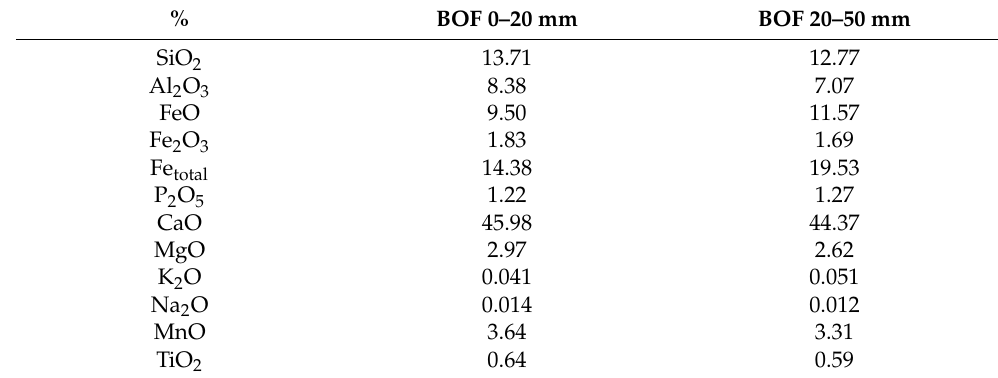
Table 1. Chemical composition of BOF slag.